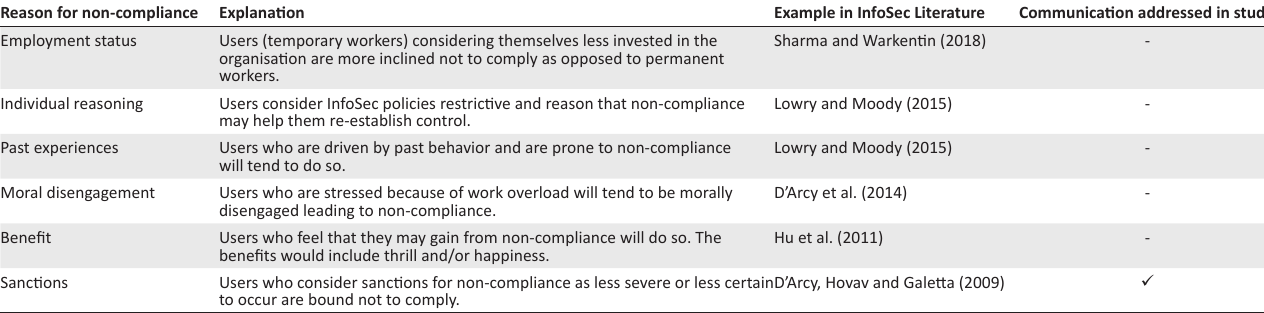
TABLE 1: Reasons for lack of compliance with InfoSec